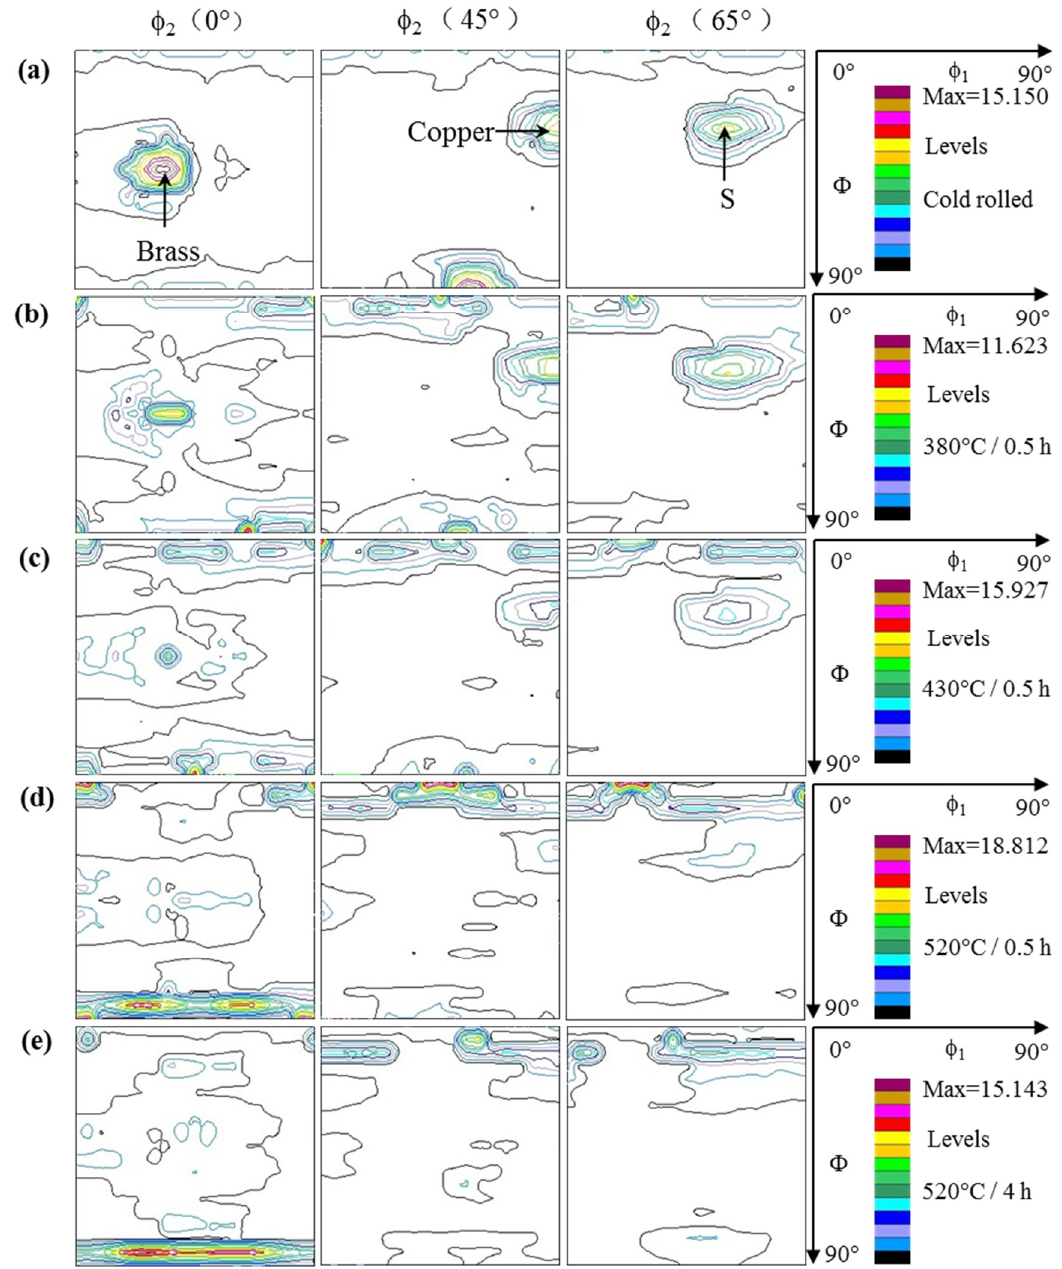
Figure 3. ODFs representative sections of cold rolled Ce-free alloy under different annealing temperatures and time: ( a ) cold rolled; ( b ) 380 °C/0.5 h; ( c ) 430 °C/0.5 h; ( d ) 520 °C/0.5 h; ( e ) 520 °C/4 h.